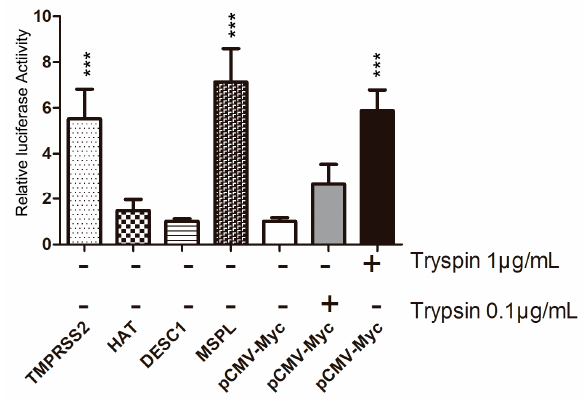
Figure 3. TMPRSS2 and MSPL activation of PEDV for cell–cell fusion. The results of a representative experiment performed with triplicate samples are shown; *** p < 0.001 vs. pCMV-Myc without trypsin. Relative quantity of pCMV-Myc without trypsin = 1. Error bars indicate standard error of the mean.